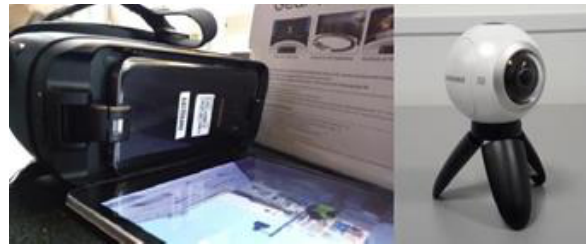
Figure 1. The VR-System, consisting Samsung Galaxy S7 phone mounted in a Samsung Gear VR, connected to a Nexus 9 tablet, and a Samsung Gear 360 to film 360° footage.